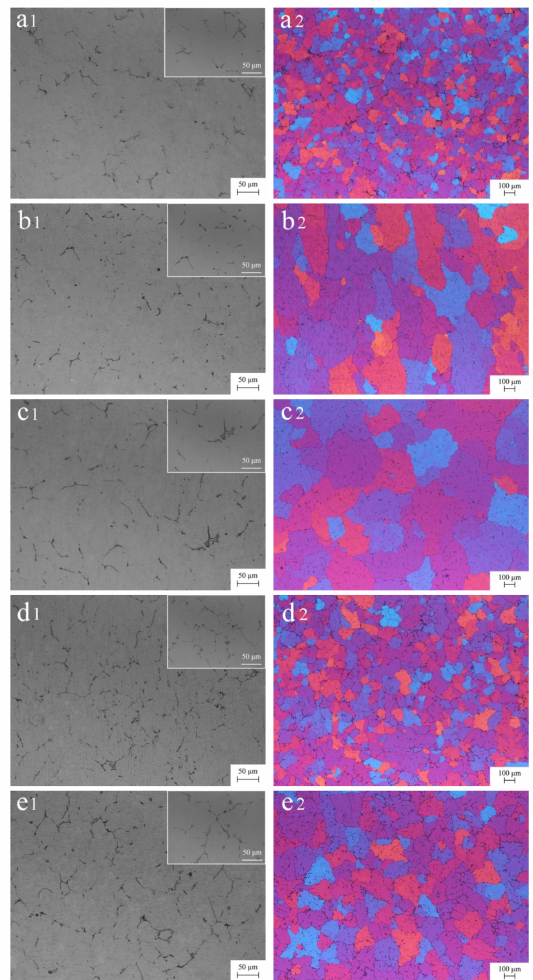
Figure 2. Metallographic structure of as-cast 5052 aluminum alloys with embedded graphs to reflect the local characteristics on the top right of images: ( a1 , a2 ) A0 without Er; ( b1 , b2 ) A1 with 0.1% Er; ( c1 , c2 ) A2 with 0.2% Er; ( d1 , d2 ) A3 with 0.4% Er and ( e1 , e2 ) A4 with 0.8%